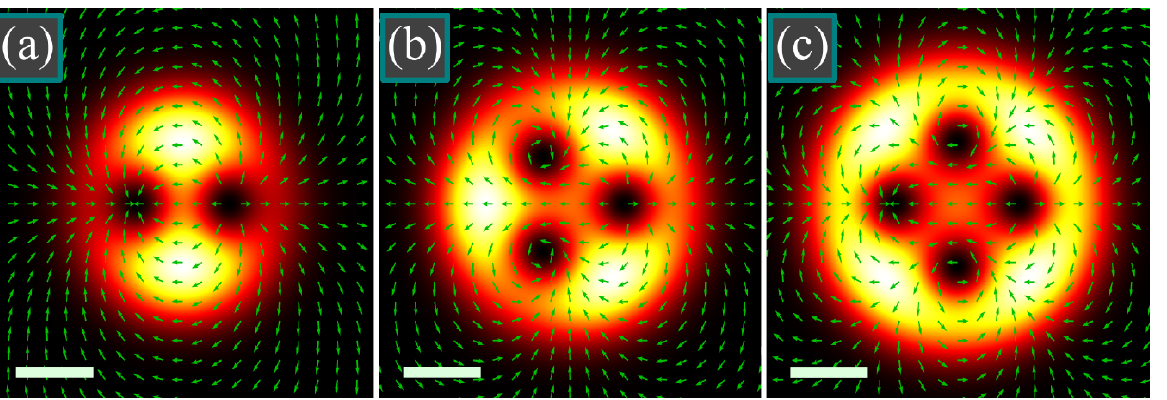
Figure 1. Intensity distributions of the light field (5) in the initial plane ( z = 0) for the following parameters: wavelength λ = 532 nm, Gaussian beam waist radius w 0 = 1 mm, number of polarization singularities m = 2 ( a ), m = 3 ( b ) and m = 4 ( c ), radius of the singularities circle a 0 = 600 μ m ( a ), a 0 = 700 μ m ( b ), a 0 = 800 μ m ( c ). Size of all figures is 5 × 5 mm 2 , scale mark in each figure denotes 1 mm. Arrows show the directions of linear polarization.